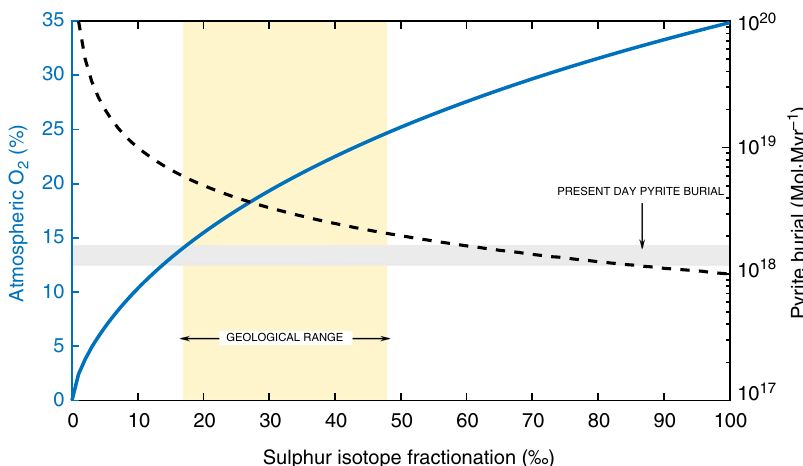
Fig. 2 The relationship between sulphur isotope fractionation and oxygen concentration in GEOCARBSULF. The blue line shows the sulphur isotope fractionation ( α s ) generated by the equation used in the original GEOCARBSULF model for different concentrations of atmospheric O 2 , and the dashed black line shows the resultant pyrite burial fl ux. The yellow box represents the bounds of the geologic record for sulphur isotope fractionation between sulphate and pyrite over the last 570 Myrs, based on datasets from Wu et al. 66 and the grey box represents estimated modern day pyrite burial levels